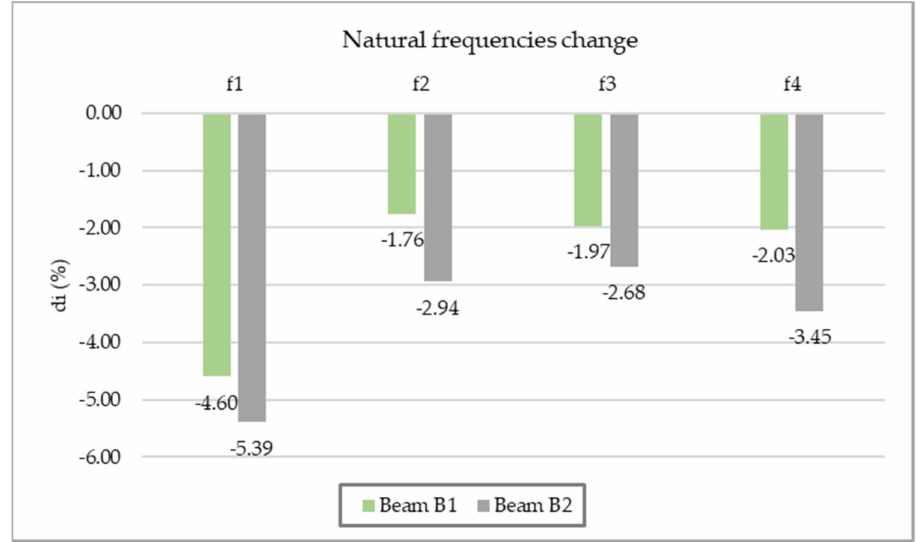
Figure 5. Representation of the change in the values of the natural frequencies for beams B1 (uncor- roded) and B2 (corroded) (author’s processing based on